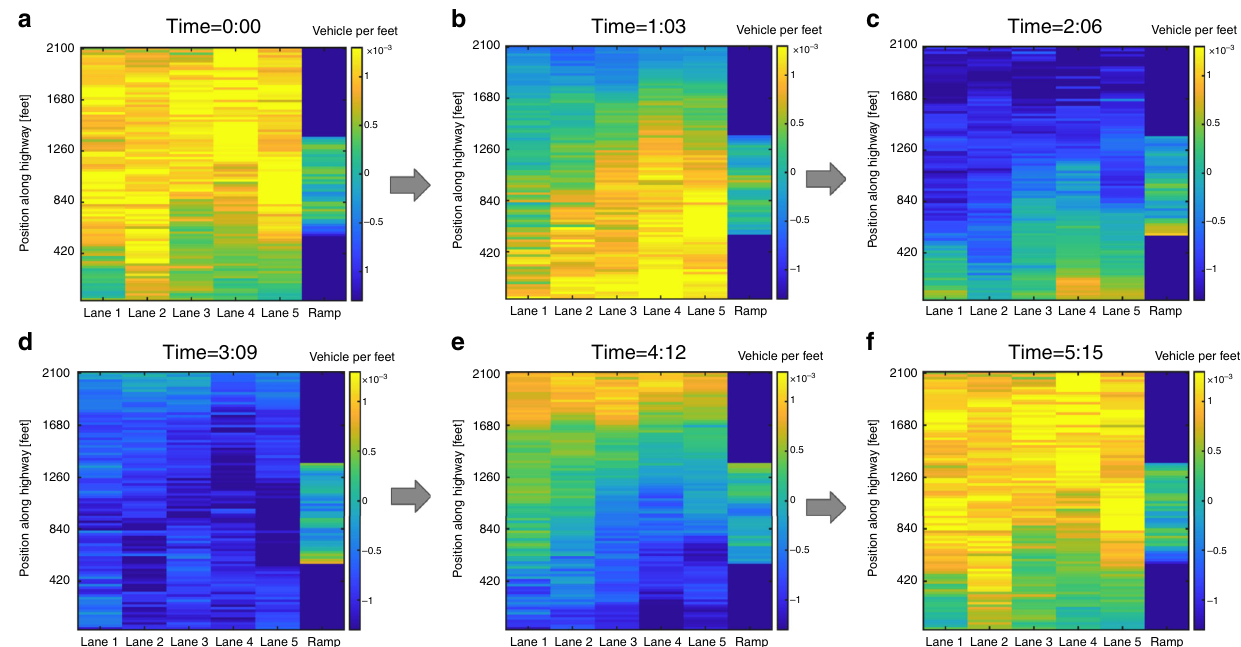
Fig. 5 Video snapshots of the seventh multi-lane Koopman mode. The mode has a period of approximately 6 minutes and the time for each fi gure is given in minutes:seconds. Mode 7 clearly captures the dynamics of a highway wide traf fi c jam. It is interesting to note how the moving localized cluster ’ s (MLC) travel can be out of phase across differing lanes. This results in the apparent top-left to a bottom-right direction of travel and is a feature impossible to recover from a single-lane analysis. Lastly, one can observe that the on-ramp density of vehicles is not merging at the time of peak congestion. Speci fi cally, the on-ramp is most heavily congested during ( c and d ) at which point the MLC has already propagated by. However, mode 14, a harmonic of this mode, clearly displays the opposite effect. This demonstrates how our multi-lane analysis can be utilized to verify the successful timing of static ramp metering algorithms and identify the correct timescales for dynamic ramp metering algorithms. Mode 14 can be referenced in Supplementary Fig.